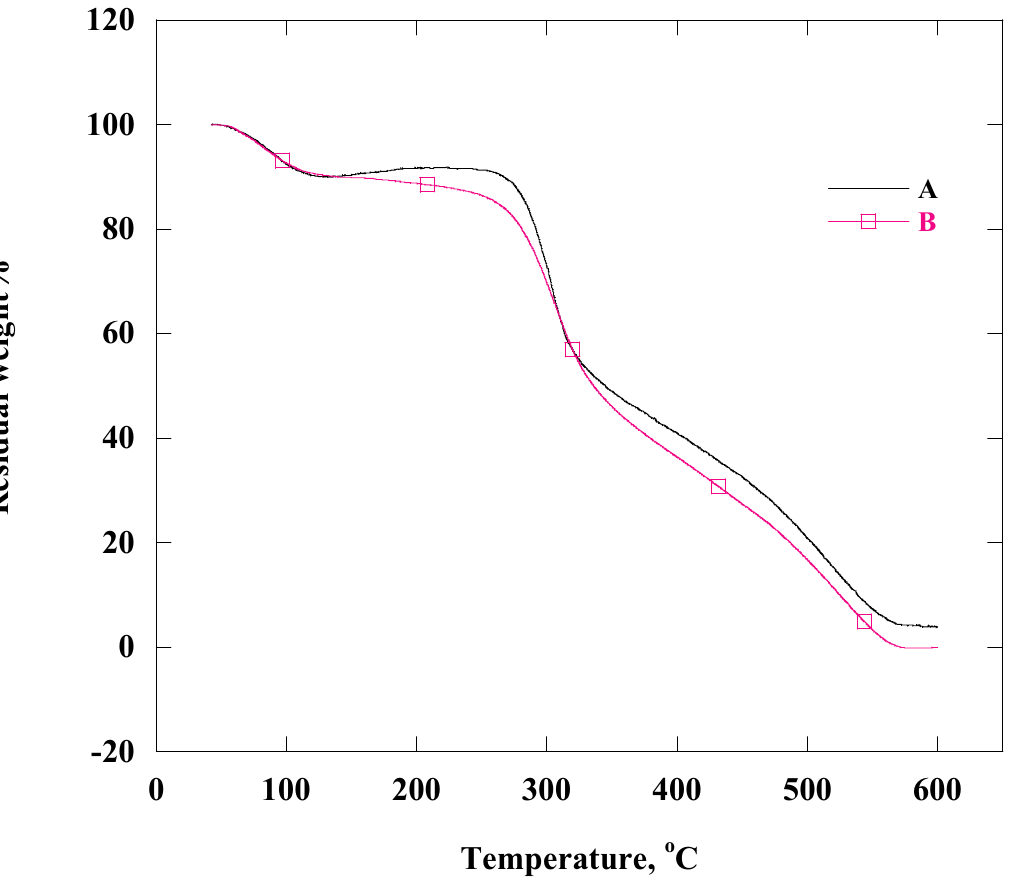
Figure 5. Thermal gravimetric analysis of (a) chitosan (b)